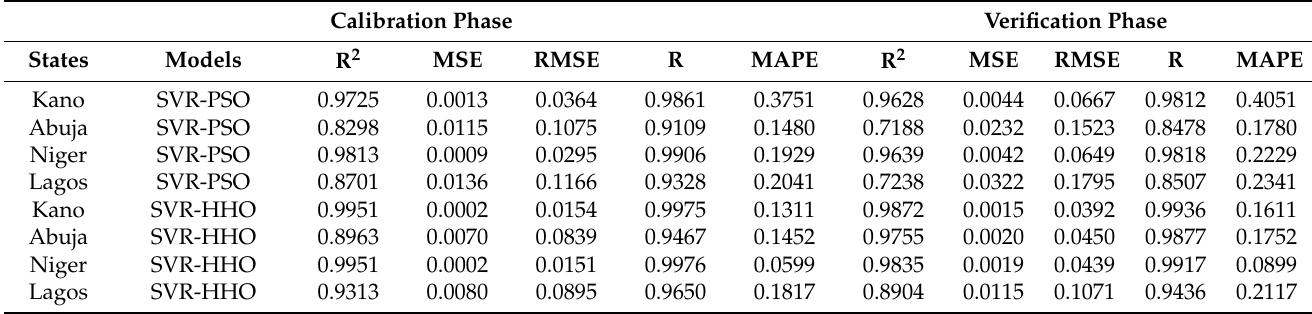
Table 2. Results of SVR-PSO and SVR-HHO for Kano, Abuja, Niger, and